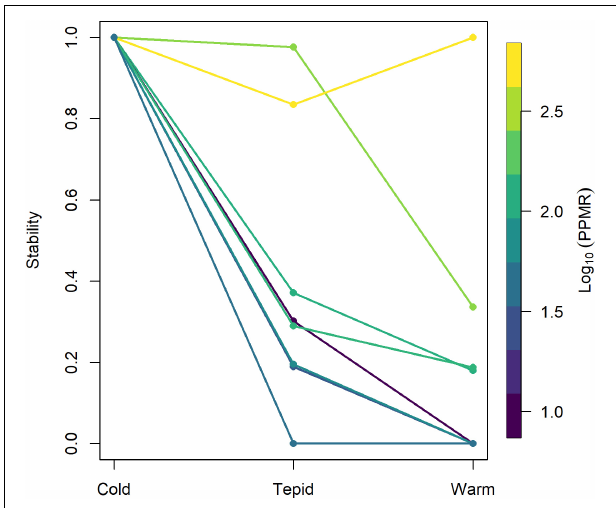
FIGURE 6 | The combined effects of temperature and predator-prey mass ratio (PPMR) on the stability of predator-prey population dynamics. Note that stability is approximately the inverse of the amplitude of predator abundances through time from population dynamical modeling (see Equation 16). A stability value of 1 indicates that predator and prey populations reach a stable equilibrium point, while a value of 0 indicates that one or both populations are lost from the